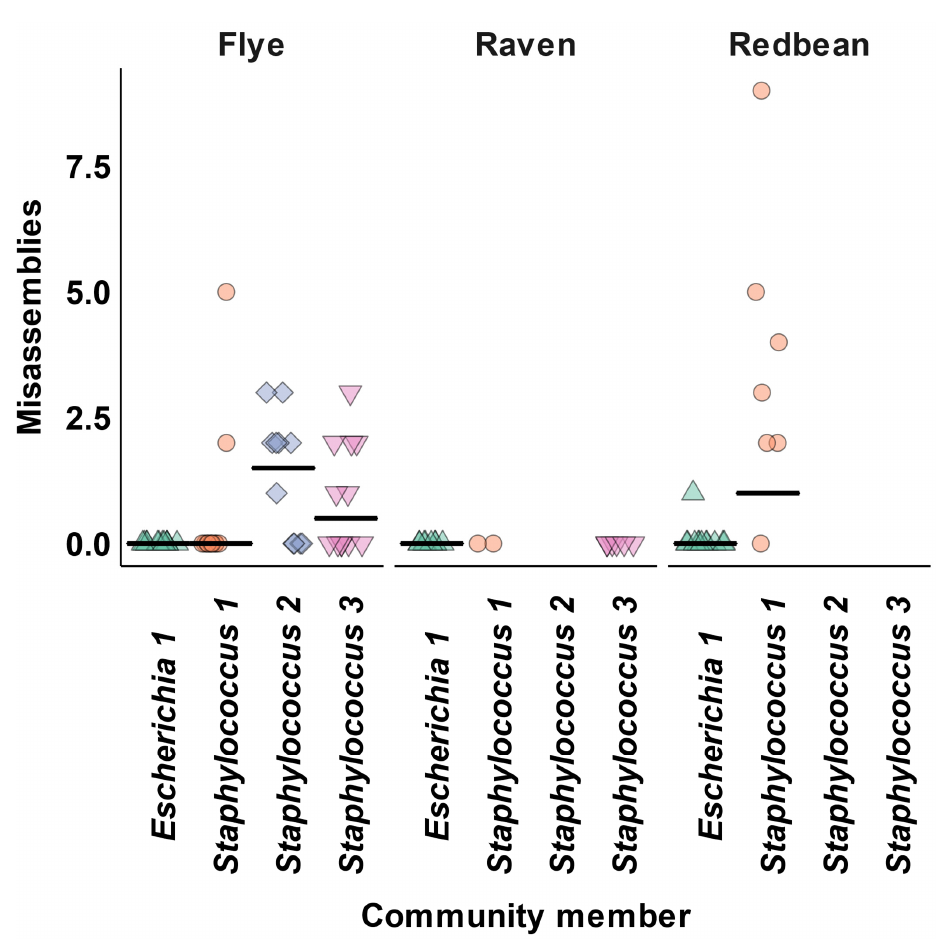
Figure A2. 30 × and 50 × plasmid completeness. Horizontal bars indicate the median across replicates. ( a ) 30 × read depth. ( b ) 50 × read depth. E. coli is 110009 bases, S. aureus 1 is 6339 bases, S. aureus 2 is 2218 bases, and S. aureus 3 is 2995 bases long.